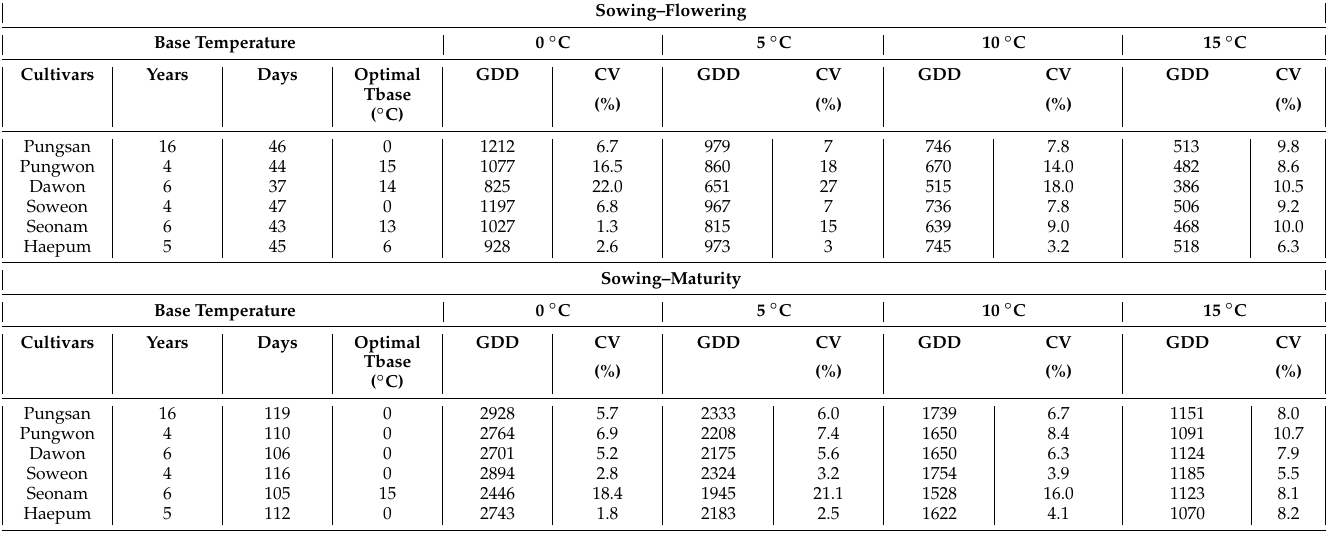
Table 4. Effect of base temperature (0, 5, 10, and 15 ◦ C) on mean growing degree days from sowing to flowering and from sowing to maturity of six soybean sprout cultivars.